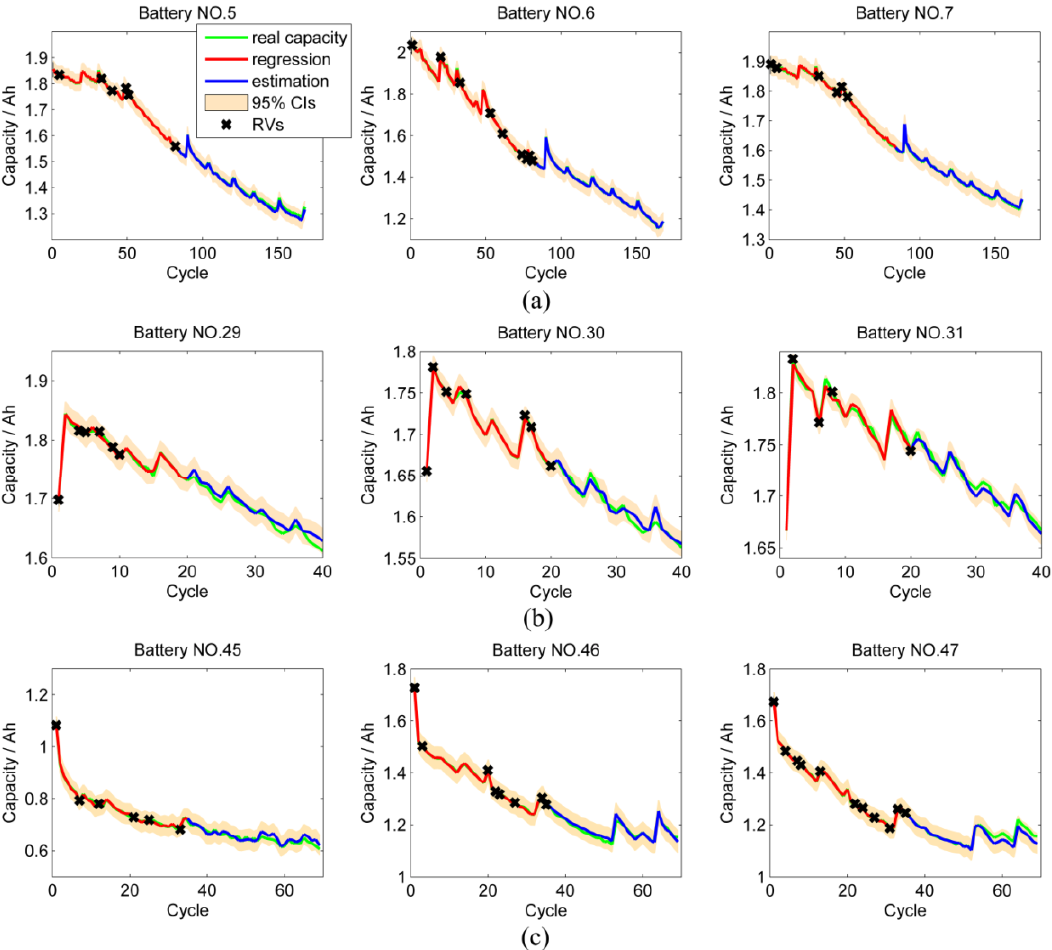
Figure 6. Regression and estimation results during the offline training and verification for the three batches of nine batteries. ( a ) Batteries 5–7; ( b ) batteries 29–31; ( c ) batteries 45–47.